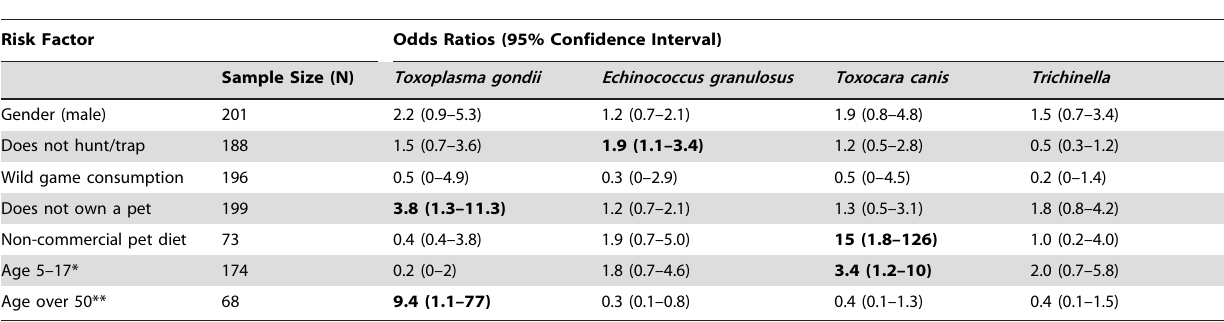
Table 3. Potential risk factors for exposure to four zoonotic parasites in a northwestern Saskatchewan community.